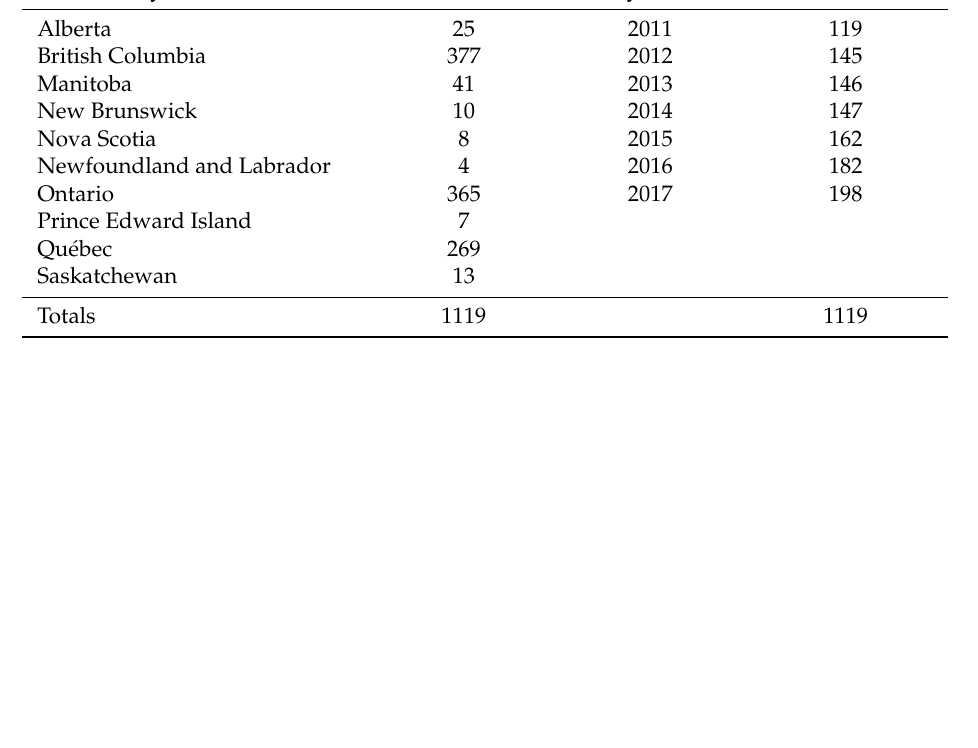
Table 1. The occurrence of Babesia duncani infections across Canada, 2011–2017. By Province Cases By Year Cases Alberta